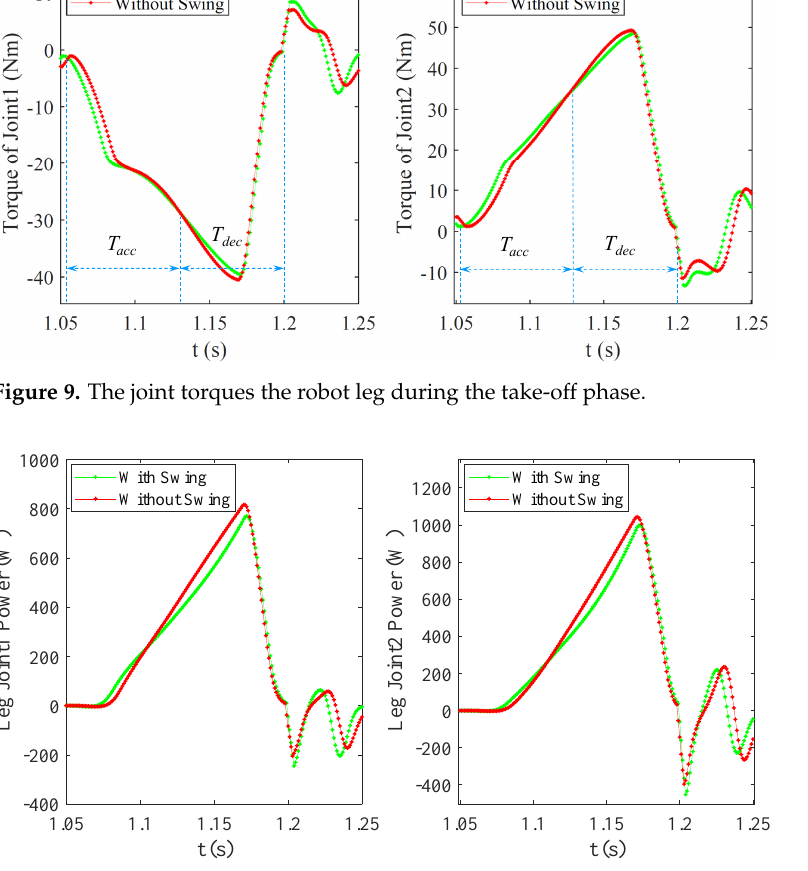
Figure 10. The joint powers of the robot leg during the take-off phase.